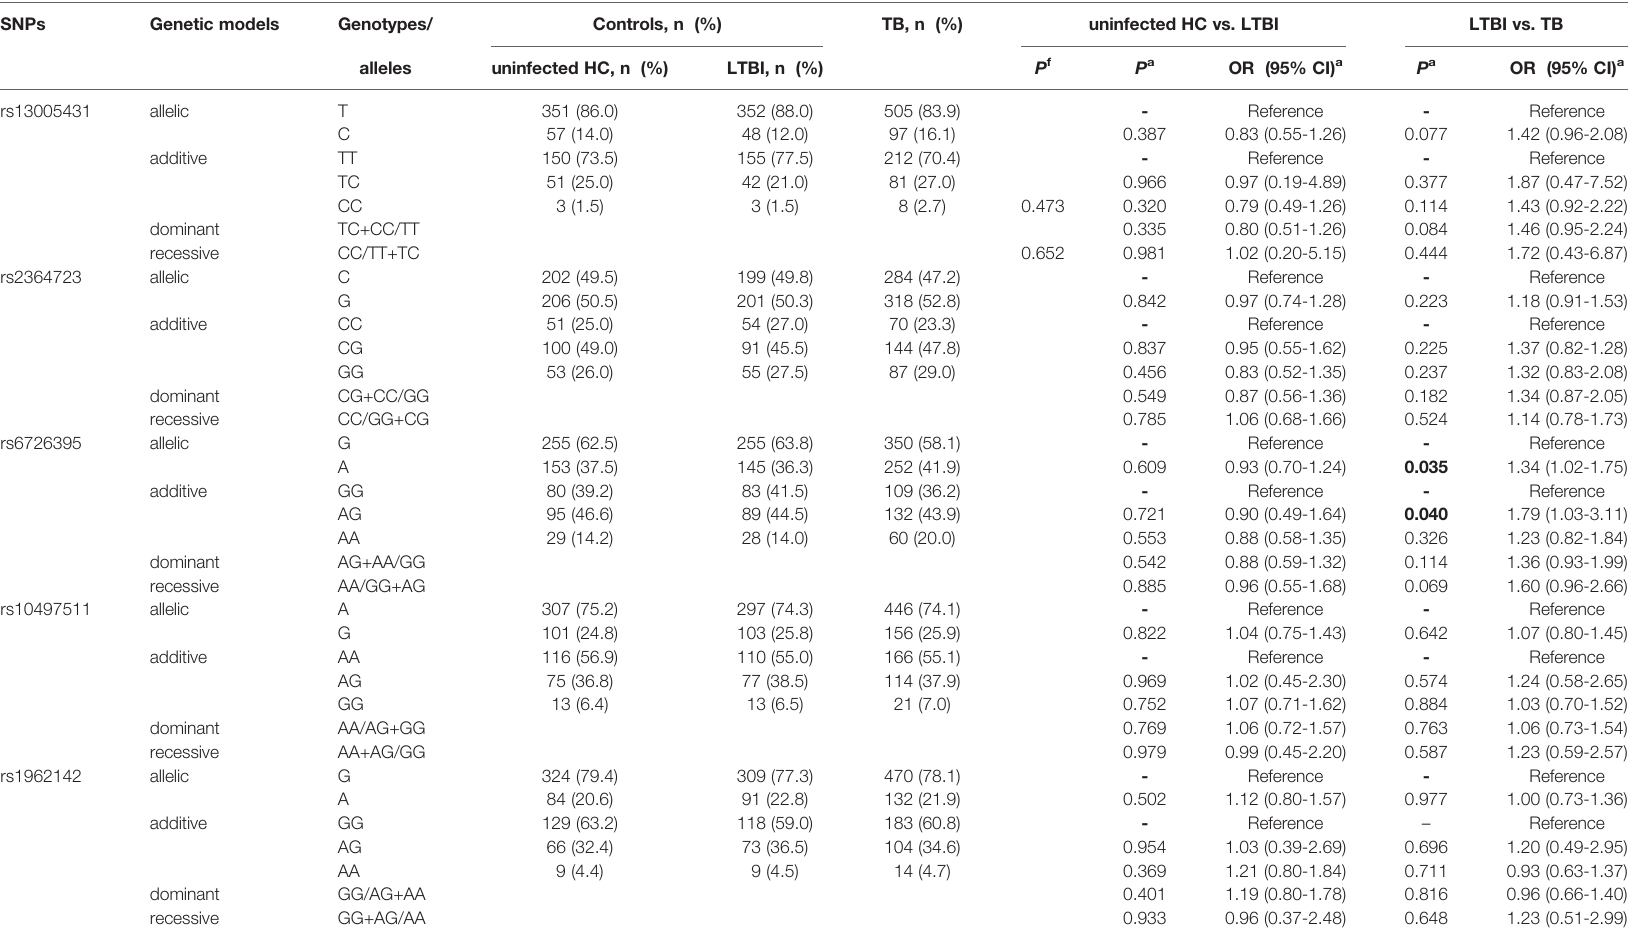
TABLE 3 | Associations between fi ve tagSNPs (rs13005431, rs2364723, rs6726395, rs10497511 and rs1962142) and risk of LTBI and TB in the replication study.